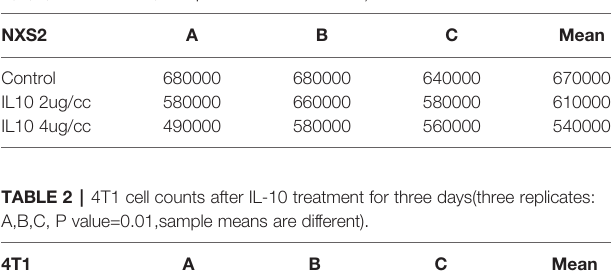
TABLE 1 | NXS2 cell counts after IL-10 treatment for three days(three replicates: A,B,C, P value=0.02, sample means are different).